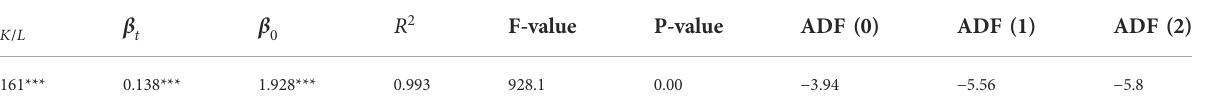
Source:DataisobtainedfromChinaStatisticalYearbook.ThevaluesreportedarecalculatedusingEq.8.***indicatesasigni fi cancelevelof1%,**indicatesasigni fi cancelevelof5%,and* indicates a signi fi cance level of 10%